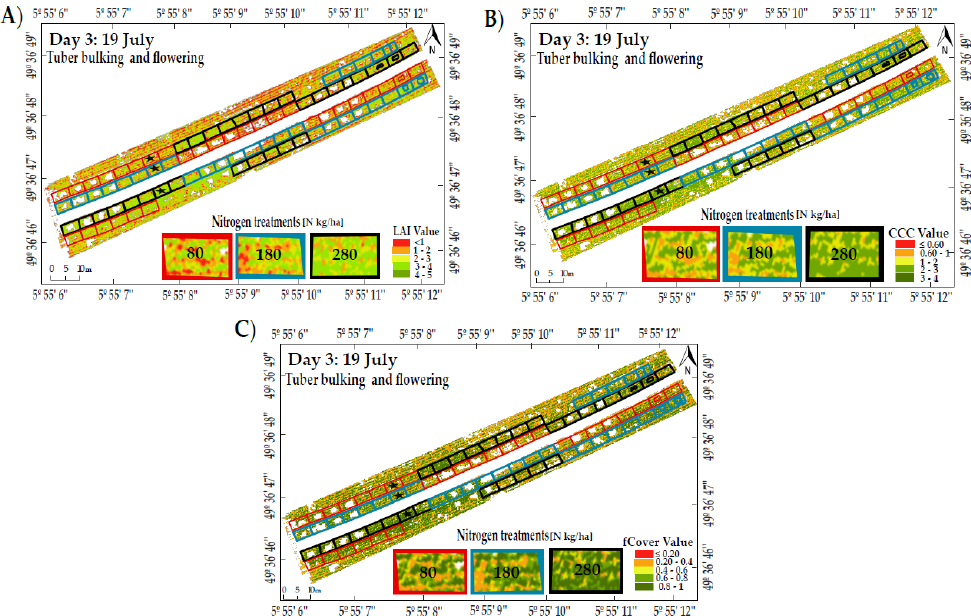
Figure 7. Predictive maps for LAI ( A ), CCC ( B ), and fCover ( C ) using RFexp under sunny day conditions (19 July). The polygons show the applied nitrogen fertilization rates for potato crop development; while the black stars present the exact locations of representative